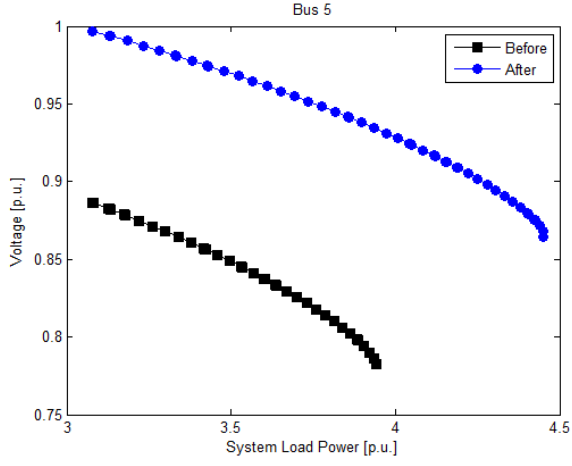
Figure 5. Simulation result of Case 1 for IEEE 9 ‐ bus.